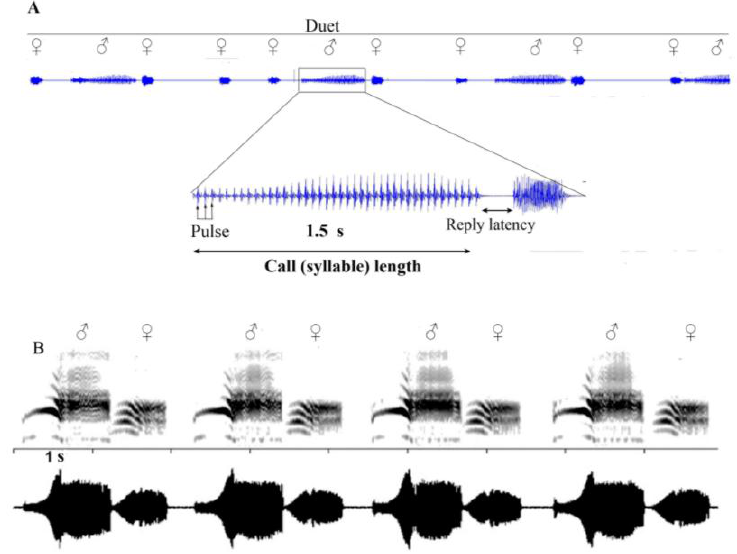
Figure 3. Vibrational duetting in triozid psyllids. ( A ) Aacanthocnema dobsoni ; long, simple male call (syllable) and short female reply (syllable). ( B ) Schedotrioza apicobystra (published with permission from CSIRO publishing) short and complex, tightly synchronized male-female duet. s =